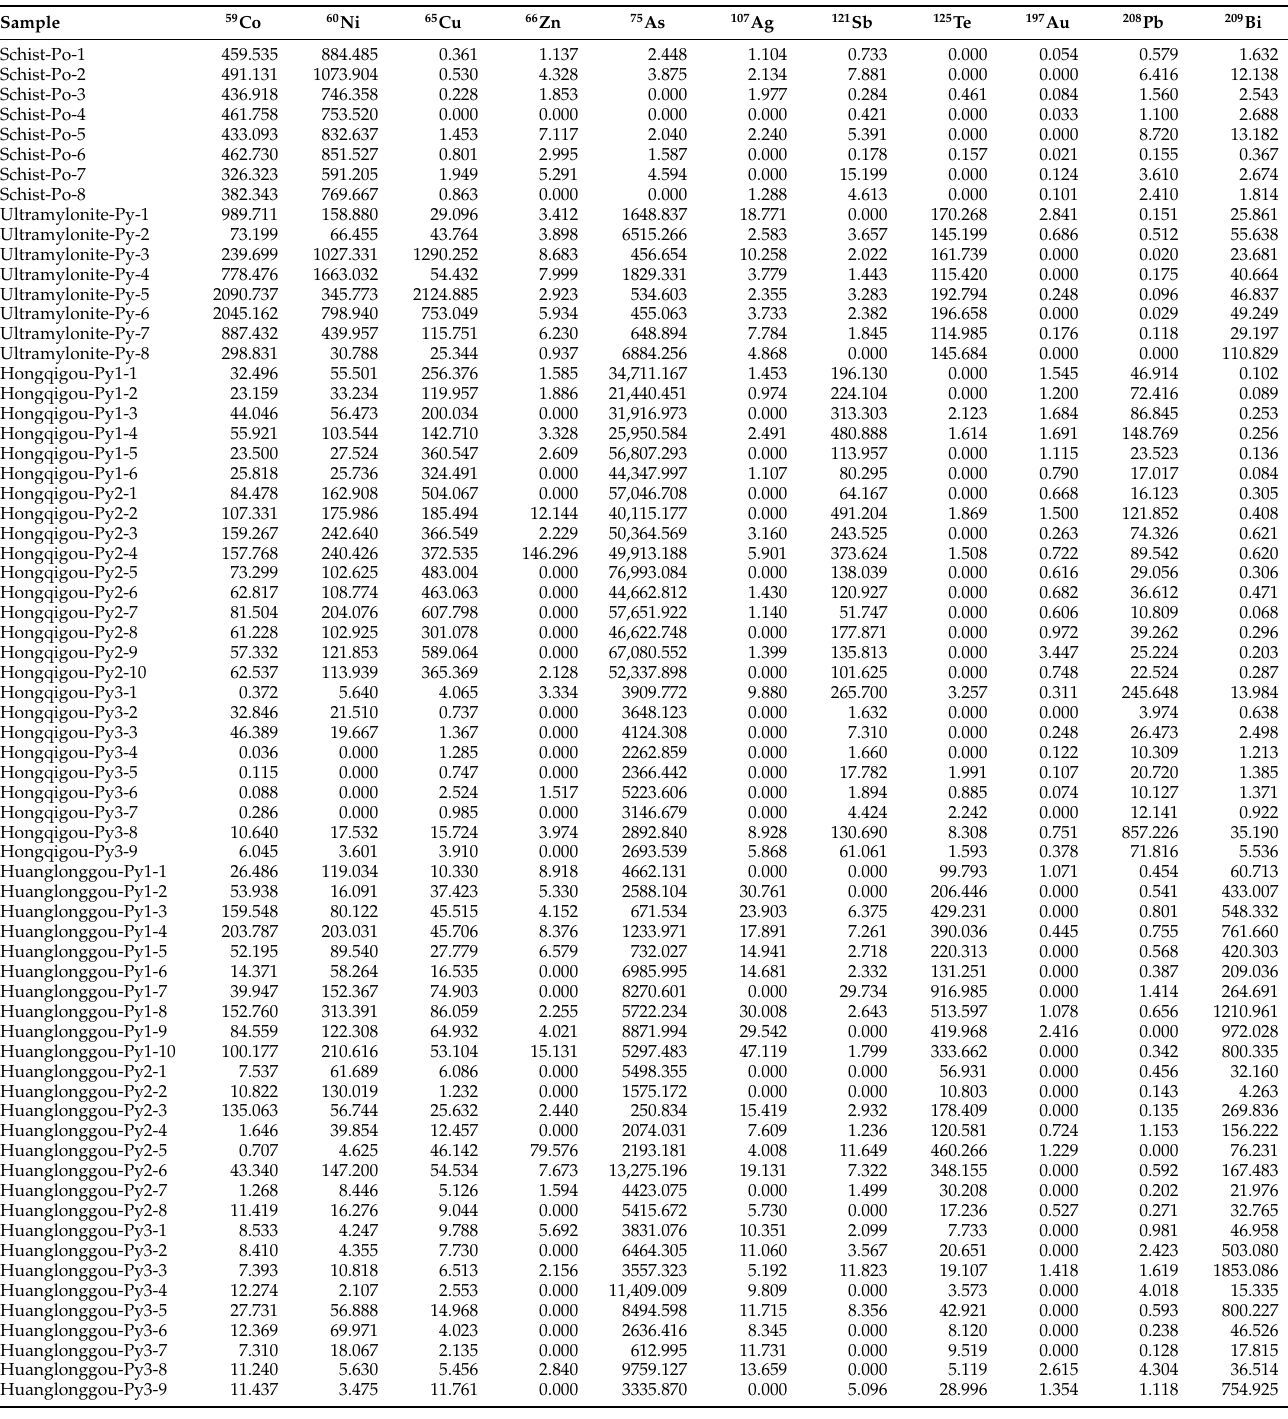
Table A1. The LA-ICP-MS analytical results of trace elements for different generations of pyrite in each stage and pyrrhotite in schist of wall rock in the Wulonggou Gold